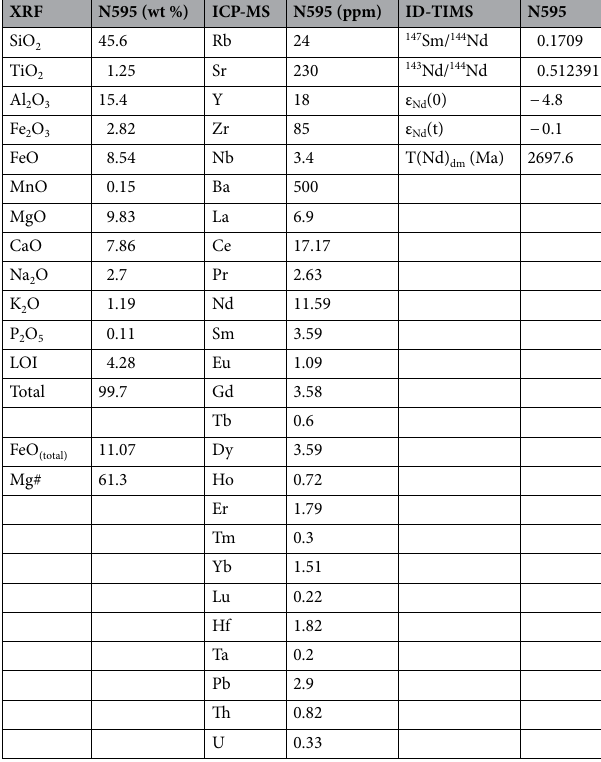
Table 1. Major, trace element and isotope data for the sample